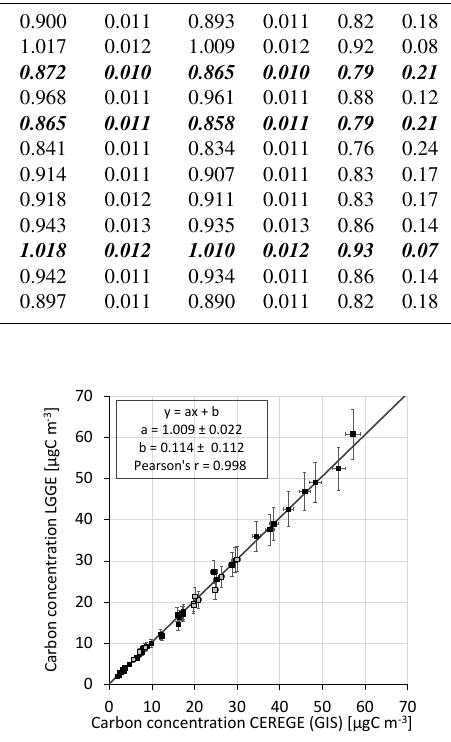
Figure 5. Total carbon concentration measurements. Comparison between TOA (LGGE in Grenoble) and GIS (CEREGE in Aix-en- Provence) measurements. The grey squares stand for the Chamonix samples and the black squares stand for the Passy samples. The regression parameters, given with their 95% confidence intervals, have been calculated by taking into account error bars on both axes and exhibit a very good correlation between the two carbon concen- trations; the two sets of measurements can be considered as equiva-